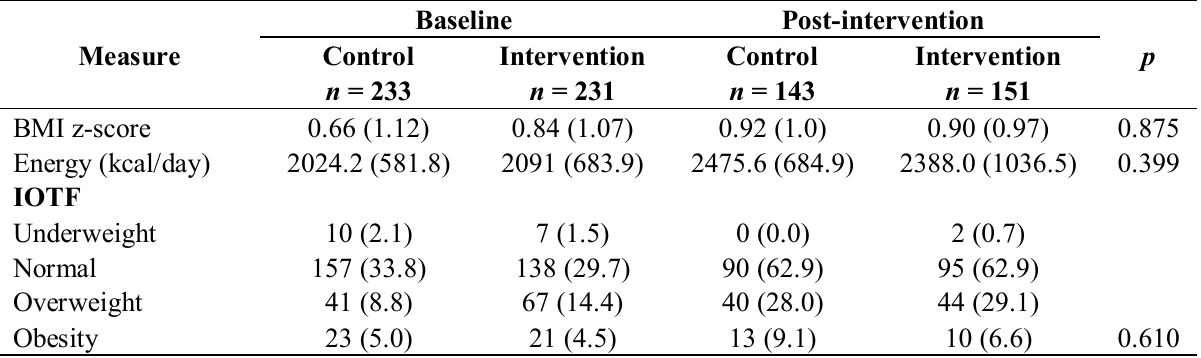
Table 2. Outcomes at